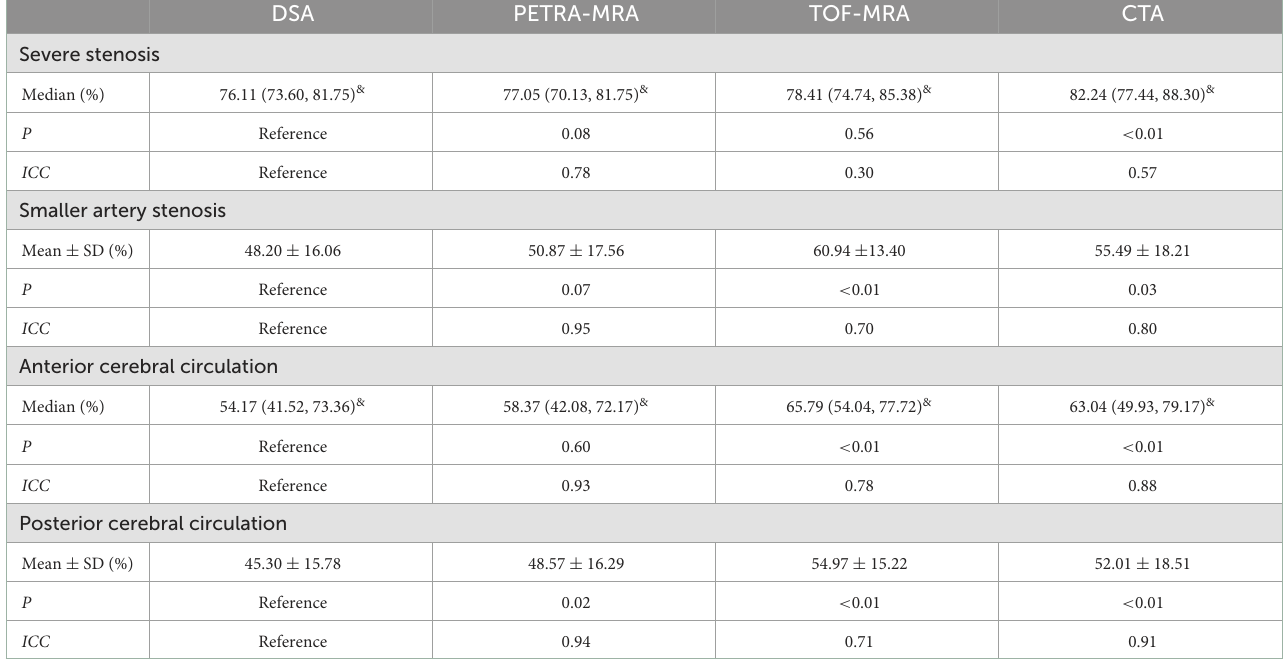
TABLE 3 Comparison of MRAs/CTA and DSA in severe stenosis, smaller artery stenosis, and anterior/posterior cerebral circulation stenosis. DSA PETRA-MRA TOF-MRA CTA Severe stenosis